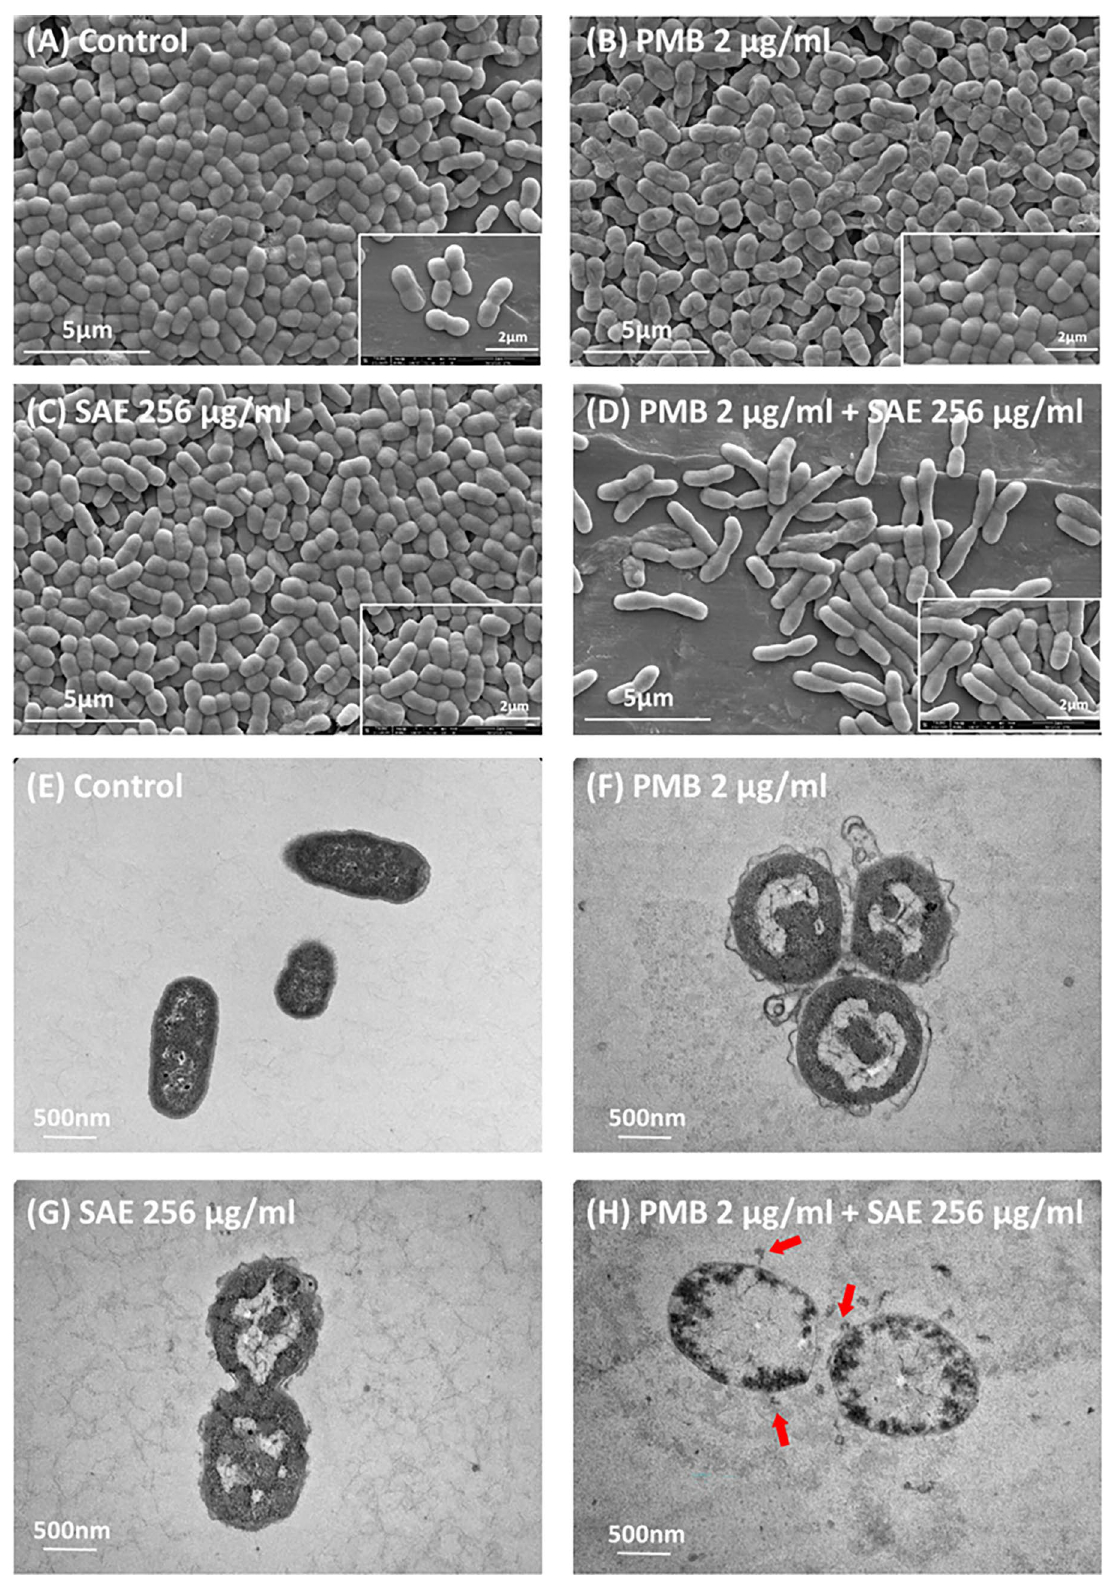
Figure 2. SEM and TEM of A. baumannii ATCC17978 cells treated with PMB and SAE. ( A ) SEM image of A. baumannii treated with DMSO as the control. ( B ) PMB for 15 min at a concentration of 4 µg/mL. ( C ) SAE for 15 min at a concentration of 256 µg/mL. ( D ) A. baumannii cells treated for 15 min with a combination of PMB at a concentration of 4 µg/mL and SAE at a concentration of 256 µg/ mL. ( E ) TEM image of A. baumannii treated with DMSO as the control. ( F ) PMB for 15 min at a concentration of 1 µg/mL. ( G ) SAE for 15 min at a concentration of 256 µg/mL. ( H ) A. baumannii treated for 15 min with a combination of PMB at a concentration of 2 µg/mL and SAE at a concentration of 256 µg/mL. Red arrows indicated membrane blebbing under a combination of PMB and